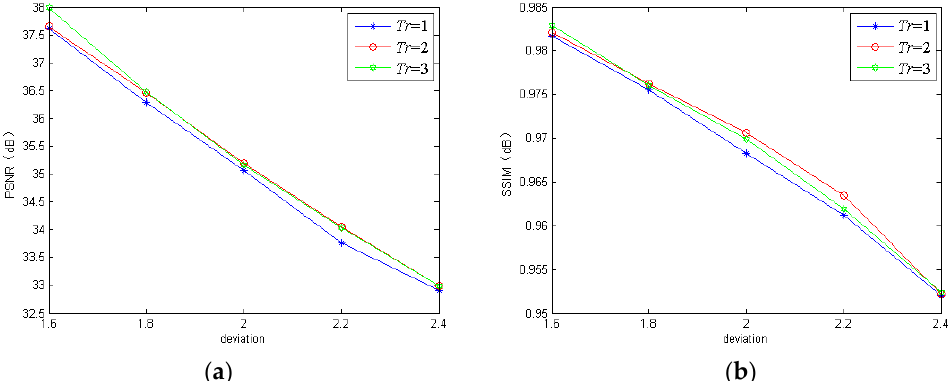
Figure 7. The PSNR and SSIM of the proposed model using different iterative times on the GoPro dataset: ( a ) PSNR; ( b ) SSIM.